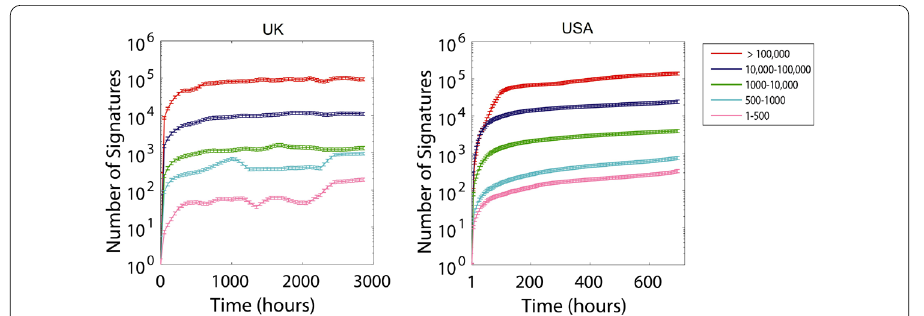
Figure 4 Growth of the number of signatures for all petitions. The UK site in the left panel and the US site in the right panel. Lines are shaded according to the total number of signatures on the petition at the end of the collection period. The curves show the average values within each interval and the error bars show the estimated standard error in calculating the average. The y -axis is in logarithmic